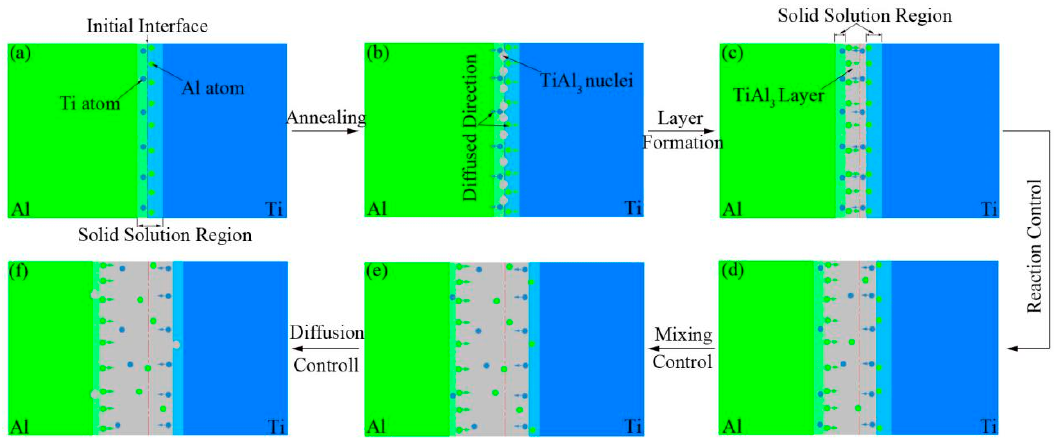
Figure 9. Schematic of the growth process of TiAl 3 layer; ( a ) welding interface, ( b ) nucleation of TiAl 3 , ( c ) formation of continuous TiAl 3 layer, ( d ) reaction -controlled, ( e ) mixing-controlled, ( f ) diffusion- controlled.